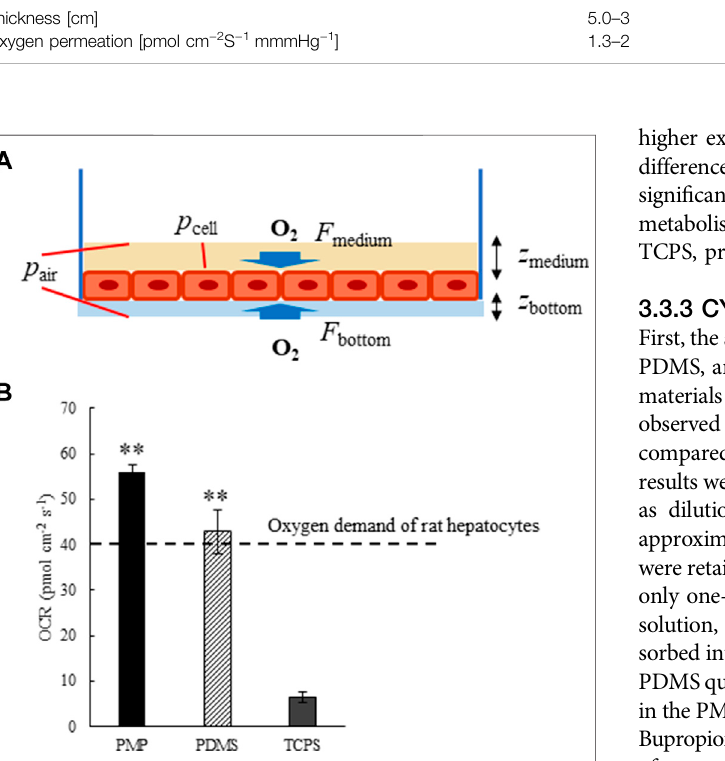
FIGURE1|(A) SchematicdiagramofOxygenconsumptionrates(OCR) calculation. F : Oxygen fl ux in the medium ( F medium ) or materials of the bottom surface ( F bottom ), p : Oxygen partial pressure at the cell layer ( p cell ) or in the air ( p air ), z : Thickness of the medium ( z medium ) or materials of the bottom surface ( z bottom ). (B) Oxygen consumption rates (OCR) of primary rat hepatocytes cultured on PMP, PDMS, and TCPS plates (**: p < 0.01, N = 3, vs. TCPS).